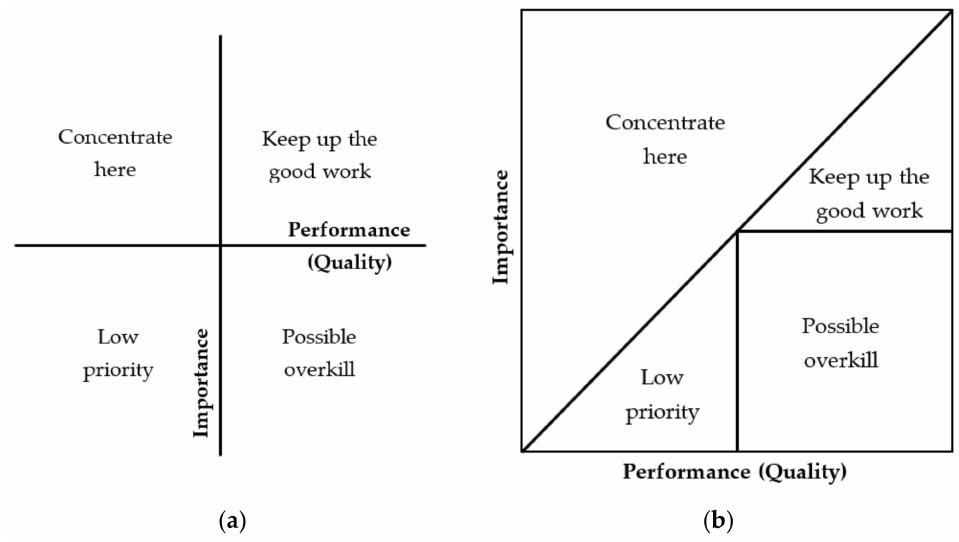
Figure 3. IPA chart: ( a ) basic, ( b ) alternative. Own study based on